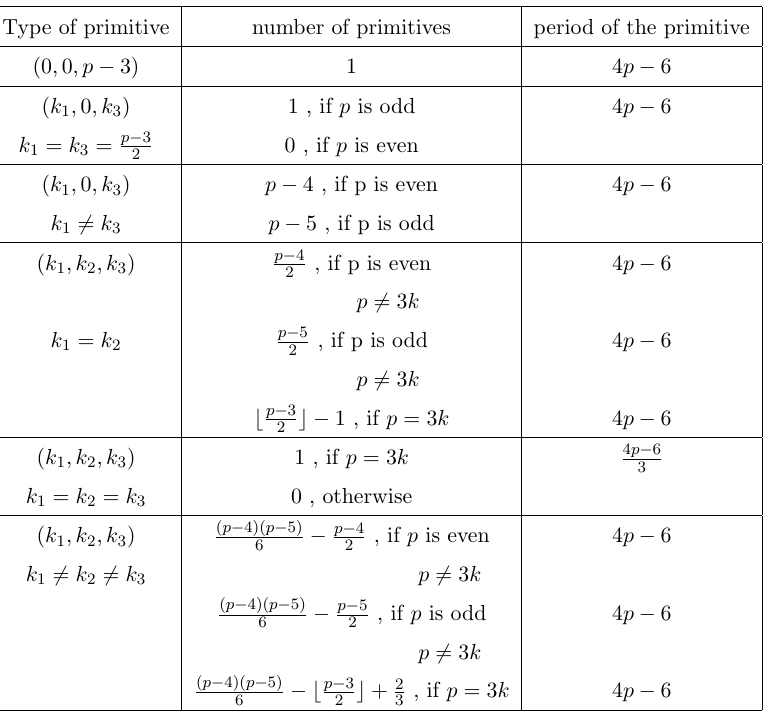
Table 2 . Primitive graphs of type